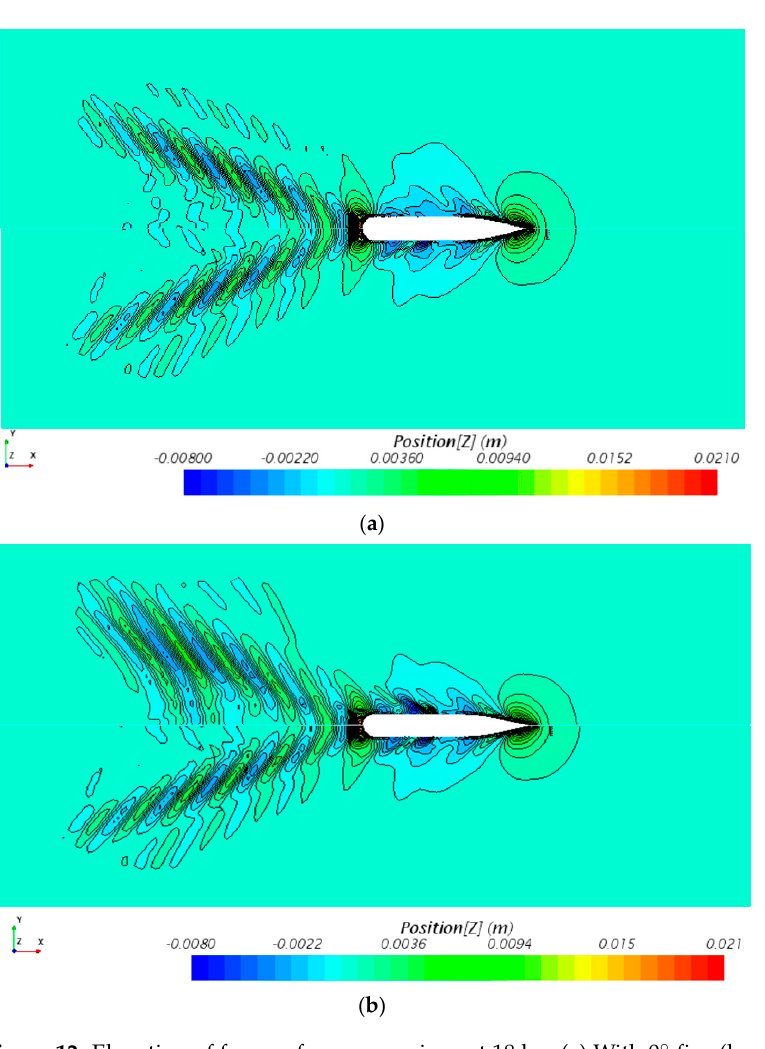
Figure 12. Elevation of free surface comparison at 18 kn. ( a ) With 0° fins (lower) and without fins (upper). ( b ) With 0° fins (lower) and with 20° fins (upper).